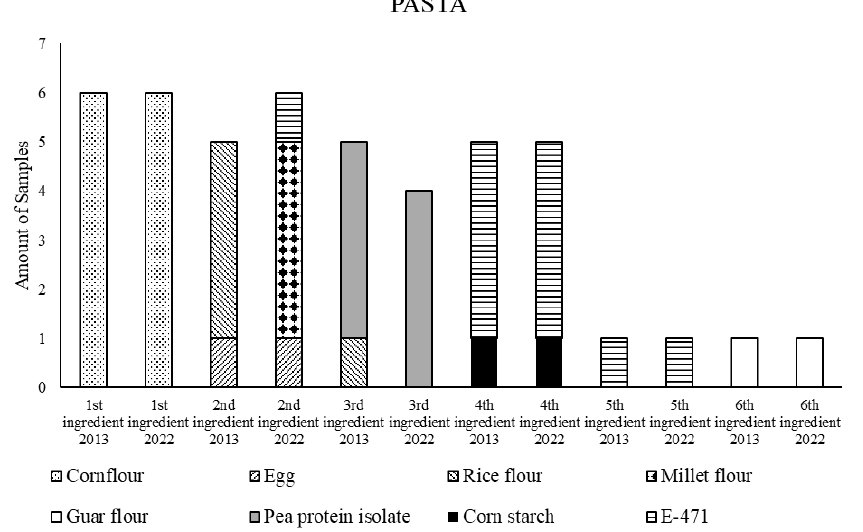
Figure 1. Comparison of the presence and weight of the ingredients used for GF pasta formulation from the most-used ingredient to the least in both 2013 and 2022. Amount of samples in which each ingredient is listed in this position is expressed according to the food label. ingredient is listed in this position is expressed according to the food